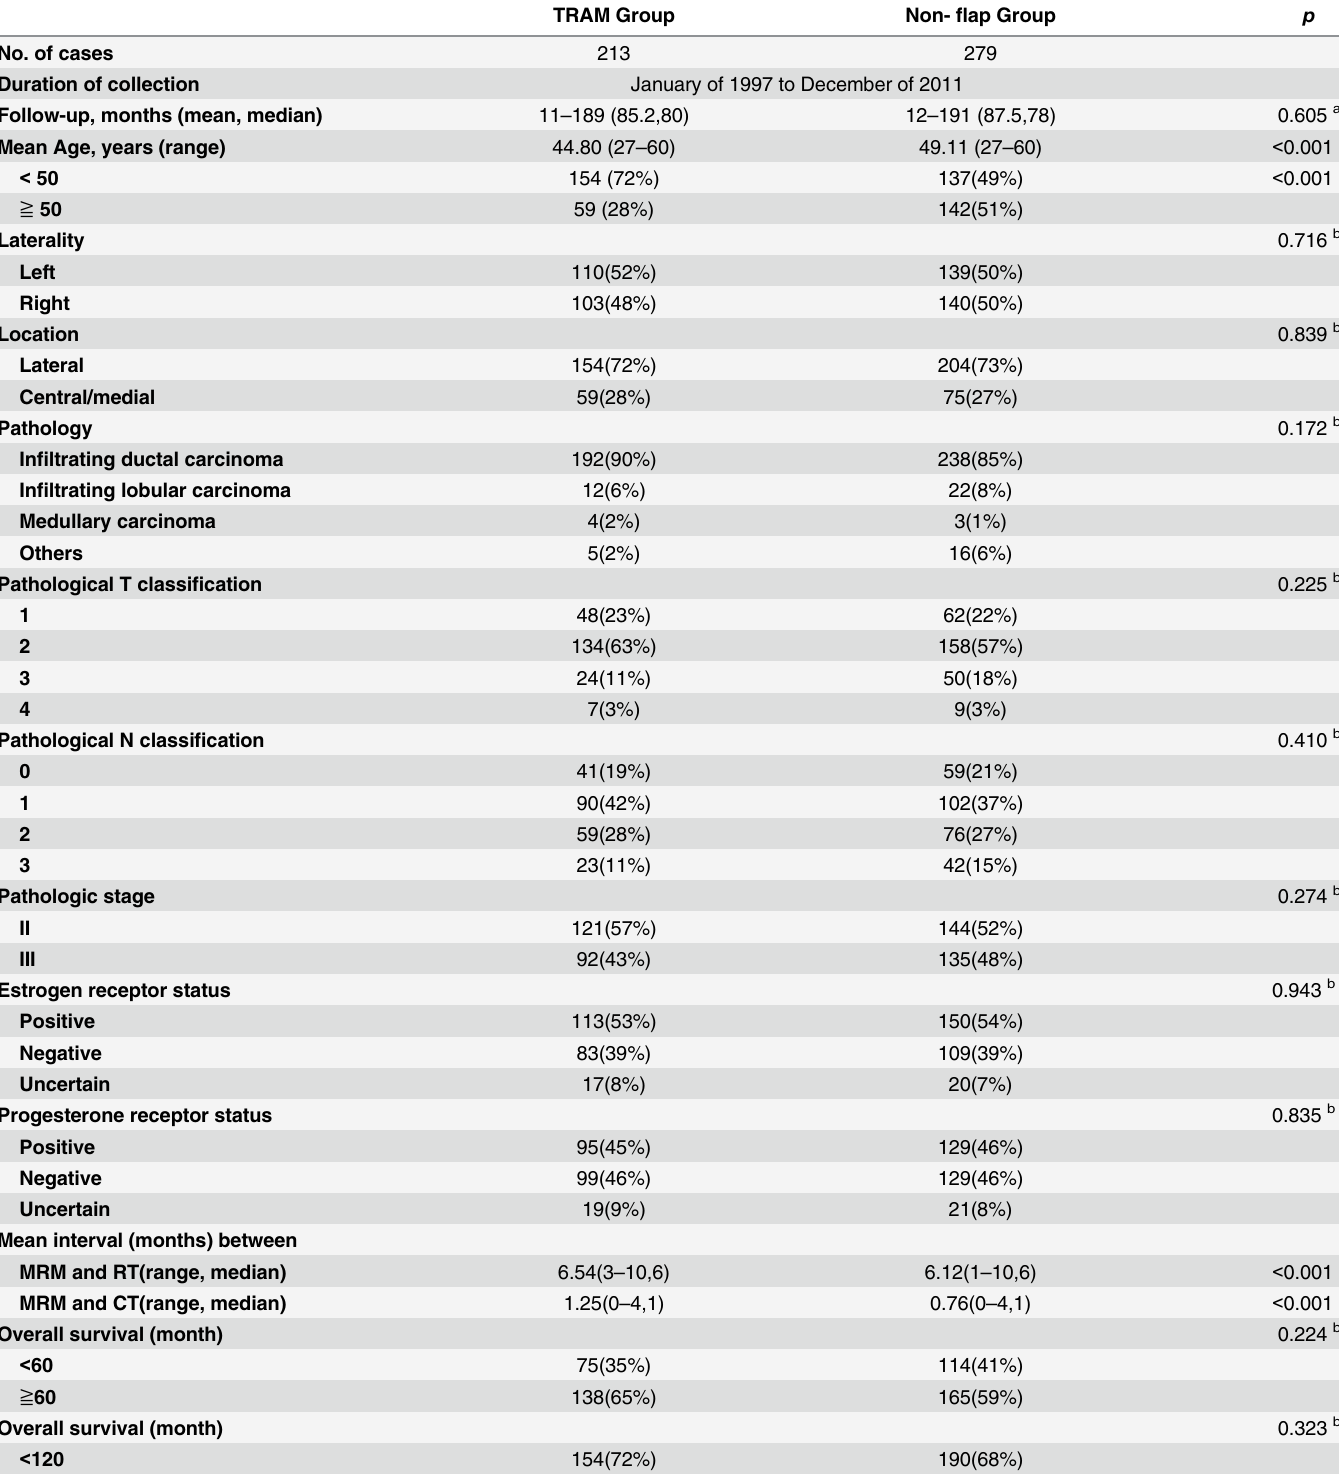
Table 1. Clinicopathologic characteristics of 492 breast cancer divided by transverse rectus abdominis myocutaneous (TRAM) flap reconstruction. TRAM Group Non- fl ap